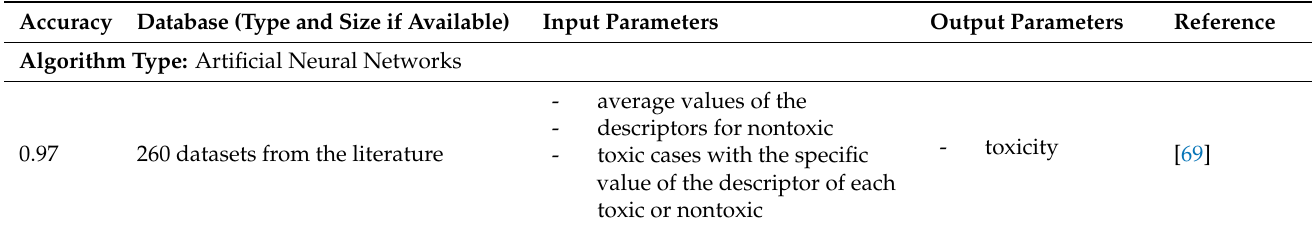
Table 3. The comparison of the algorithms for prediction of the nanoparticle